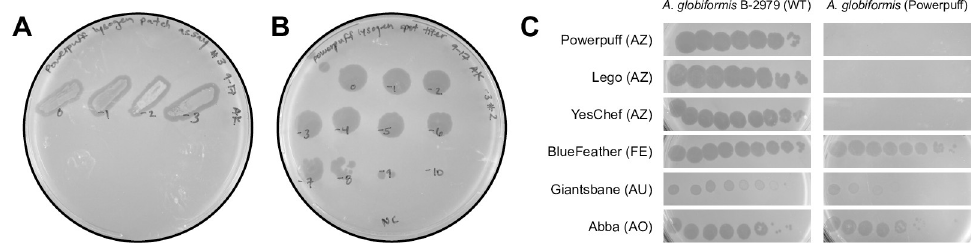
Fig 8. Phage Powerpuff forms stable lysogens that are immune to superinfection by related phages. (A) Purified putative lysogens were streaked on a prepared lawn of A . globiformis B-2979. Zones of clearing were indicative of phage release. (B) Putative lysogens were grown in liquid culture then pelleted, after which supernatant was spot tested on A . globiformis B-2979 for titer. Plaque formations indicated spontaneous liquid release of phage particles and verified presence of stable lysogens. Two individual plaques were observed at the 1x10 -9 dilution, giving a titer of ~1x10 12 PFU/ mL of released phage. (C) 1:10 dilutions of Arthrobacter phage lysates were plated on WT A . globiformis B-2979 (left) and Powerpuff lysogens (right). Closely related phages were unable to lyse the Powerpuff lysogen, while unrelated phages retained infectivity with reduced